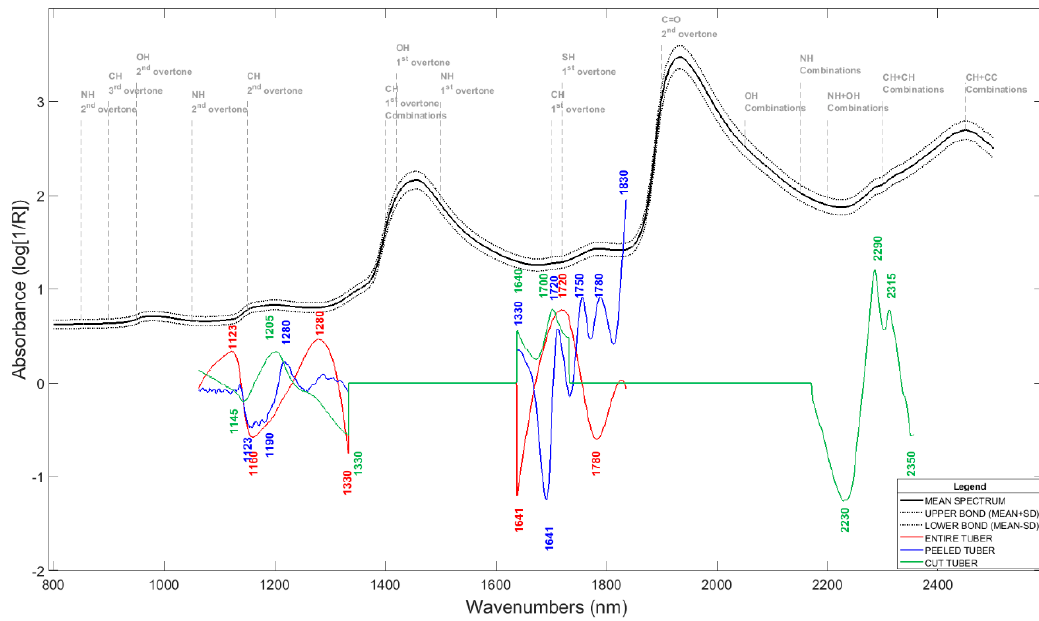
Figure 2. Mean spectra and beta-coefficients of the first PLS models latent variable to predict the DMC based on spectral data acquired on entire tubers (red line), peeled tubers (blue line), and cut tubers (green line).